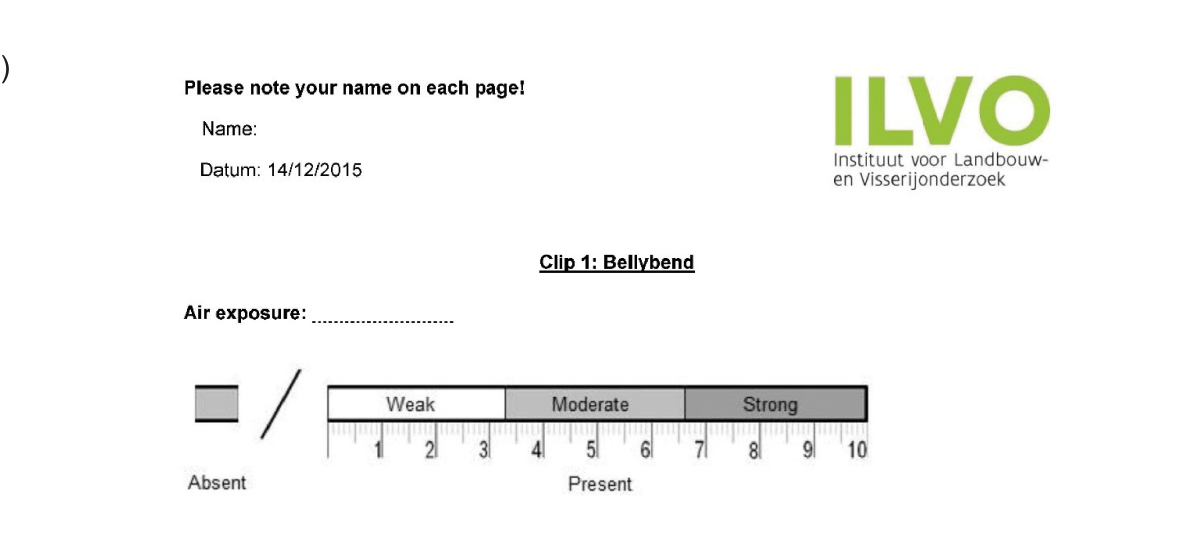
Fig 2. Example of a pictogram handout (A) and scoresheet (B) to train and score reflexes from video clips. The scoresheet details how to score the body flex reflex (which was also termed ‘bellybend’) response of common sole ( Solea solea ) on a continuous tagged-analogue visual scale from a short video